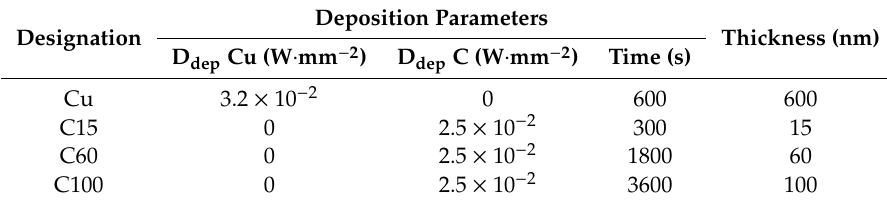
Table 1. Designation, deposition parameters, and thickness of copper and carbon deposited thin